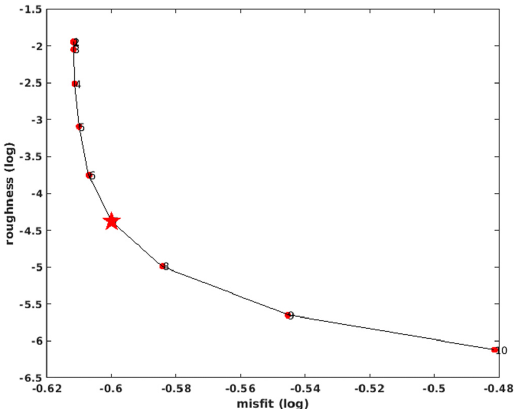
Figure 6. Trade – off curve between the misfit and model roughness. The star indicates optimal Figure 6. Trade–off curve between the misfit and model roughness. The star indicates optimal smoothing factor. smoothing factor.